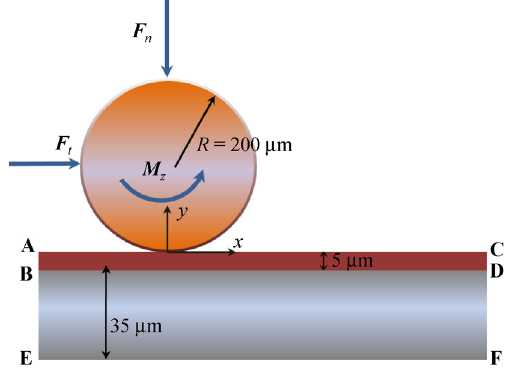
Fig. 1 Schematic representation of the scratch system including an indenter, a thin coating, and a substrate. The boundary EF is fixed during scratch